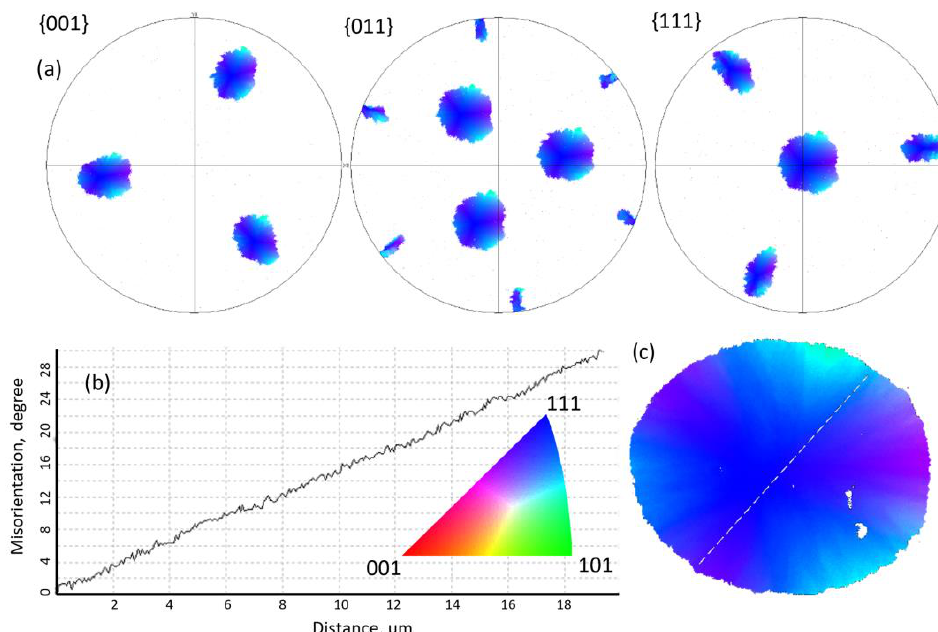
Figure 7. ( a ) Straight pole figures (SPF) for {001}, {011}, and {111} directions, colored in IPF Z colors. Colored according to the coincidence of directions on the inverse pole figure (IPF) for the macroscopic Z-axis of the sample with the color-coding triangle. It allows matching the set of direction outputs (orientation) of the crystal lattice with its position on the IPF Z map of the investigated area. ( b ) Cell misorientation dependence on the distance from the center of spherulite (corresponds to dashed line on c). ( c ) Spherulite with the color palette corresponds to the z orientation. Glassceram substrate.